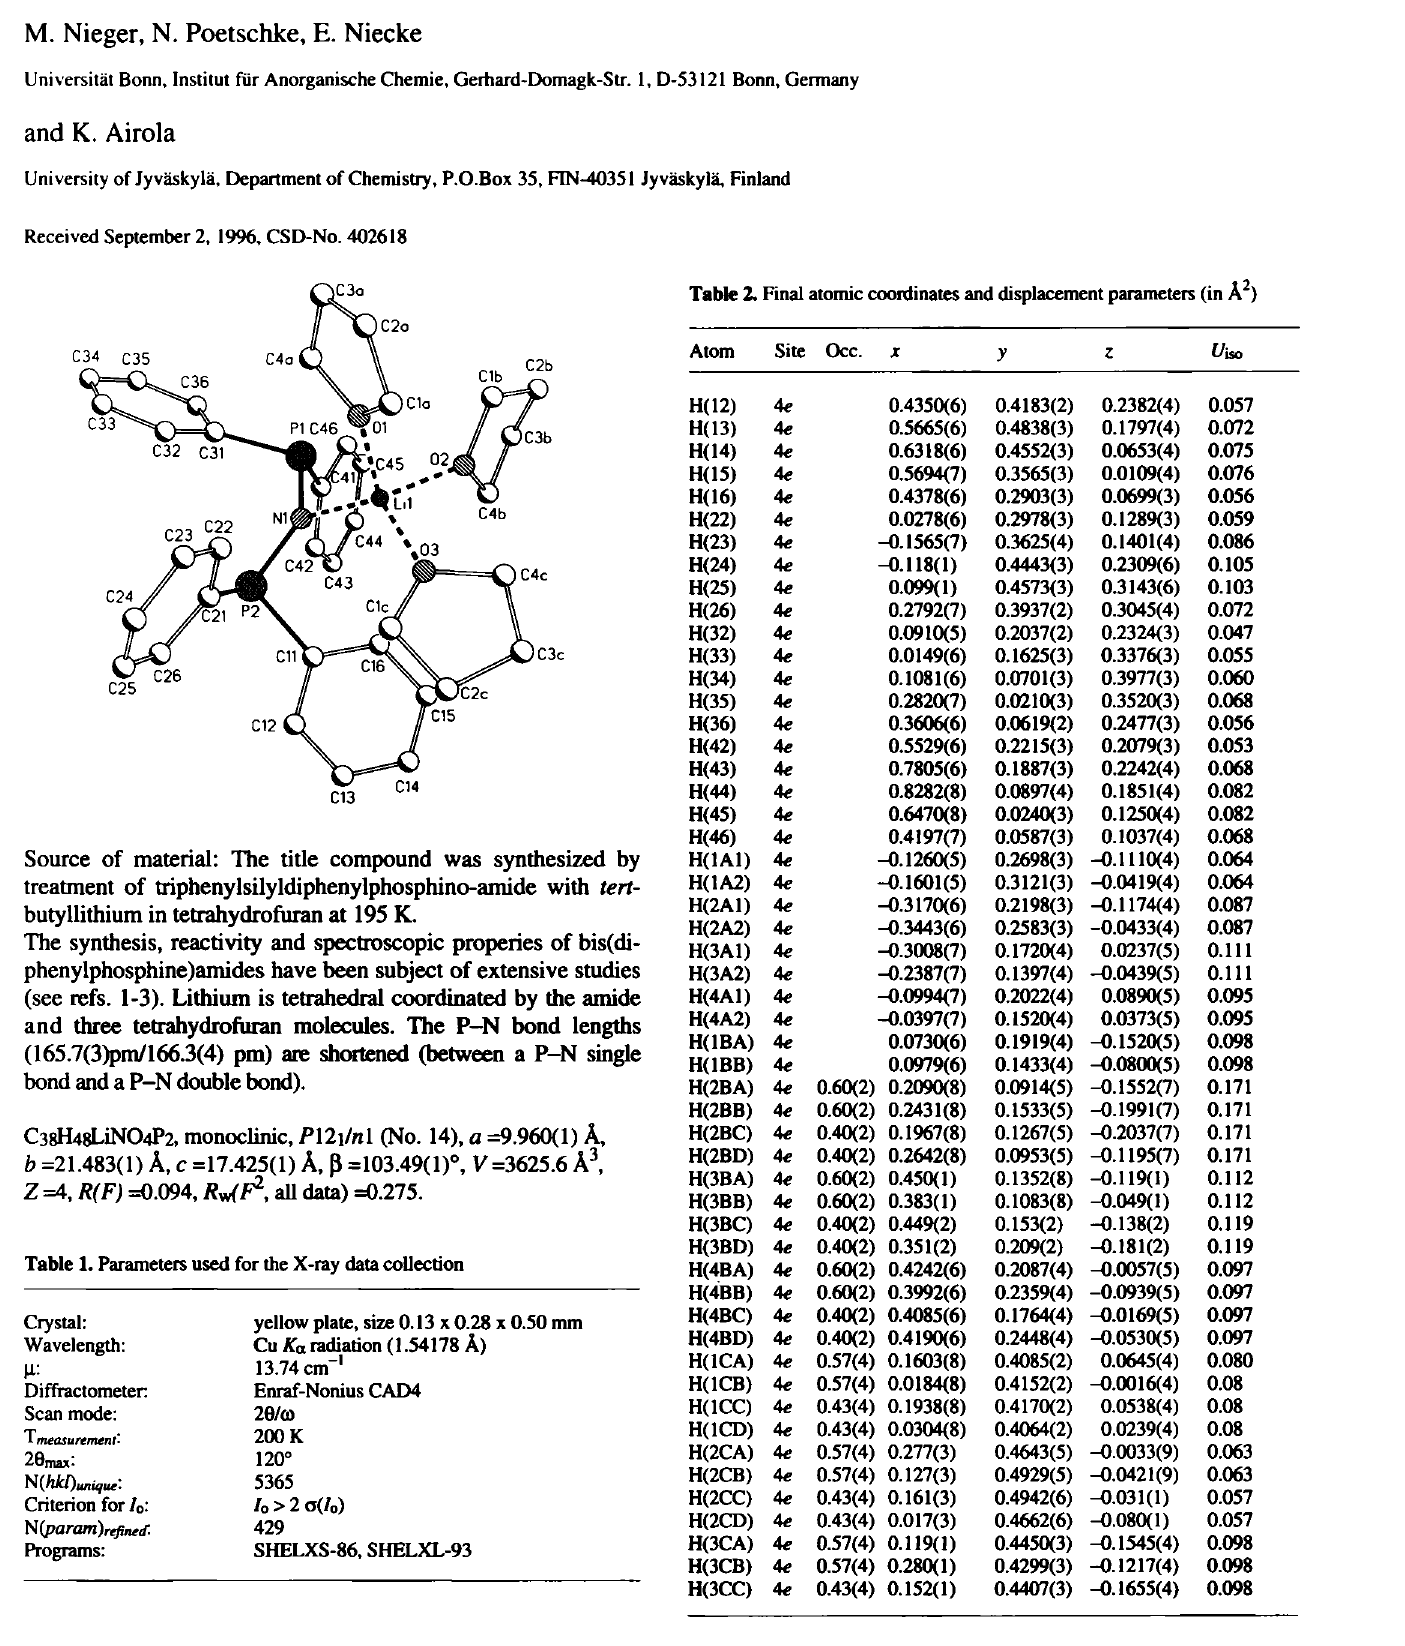
Table 2. Final atomic coordinates and displacement parameters (in Â 2